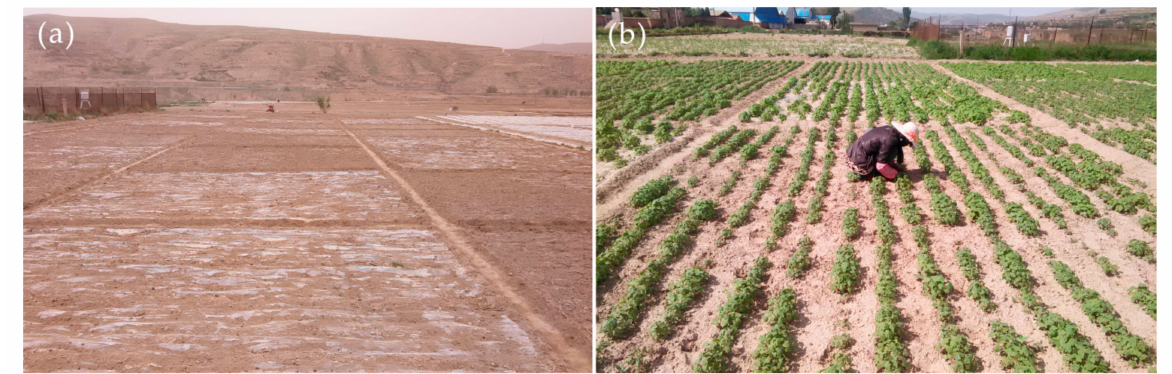
Figure 2. ( a ) Experimental plots after sowing, mulching, and fertilizer application using an inte- grated seed drill and mulching machine; ( b ) different experimental treatments of film mulching and fertilization levels at Dingxi Dryland Experimental